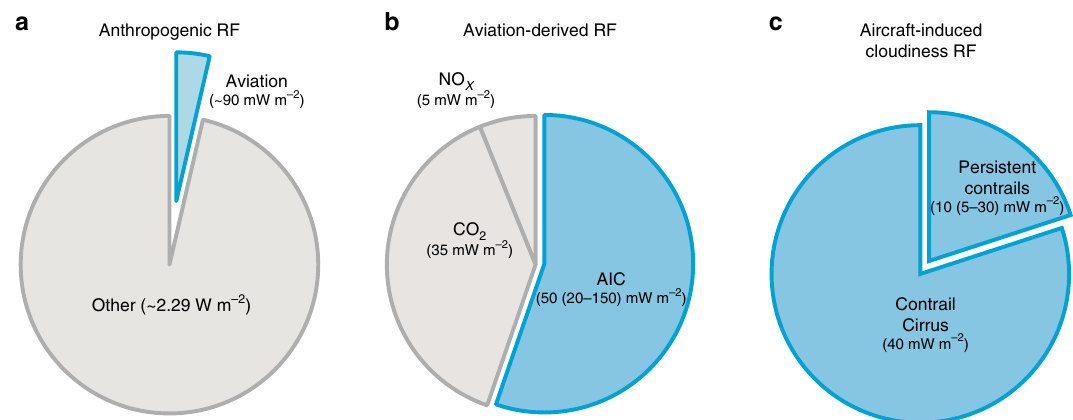
Fig. 1 Aviation radiative forcing components. a Aviation as a percentage of total global radiative forcing (RF) due to human activities in the year 2011 relative to pre-industrial times, 2.29 (1.13 – 3.33) W m − 2 (ref. 7 ). b Forcing components within the aviation fraction, of which aircraft-induced clouds (AIC) account for more than half. AIC and carbon dioxide (CO 2 ) estimates represent 2011 emission levels 10 ; the latter contribution has been obtained by extrapolating the year 2005 value 11 using the corresponding increase in scheduled air traf fi c distance (Table 7.SM.2 in ref. 10 ). RF estimates for all aviation components together for the same year and emission levels superseding 2005 values are not available 13 . Aircraft emissions of nitrogen oxides (NO x ) cause positive and negative RF contributions, values here calculated based on refs. 107,139 . Small direct RF contributions from aircraft water vapour 140 and particle emissions 14 together nearly cancel out and are therefore not shown. No scienti fi c consensus has been reached regarding the sign of RF due to modi fi cation of natural clouds by particle emissions. Therefore, the RF caused by those ‘ indirect ’ effects is not considered here, but may be of opposite sign and as large as that of AIC. c Breakdown of AIC radiative forcing into contrail cirrus and persistent contrails based on ref. 10 Table 1 Characteristics of contrails and contrail